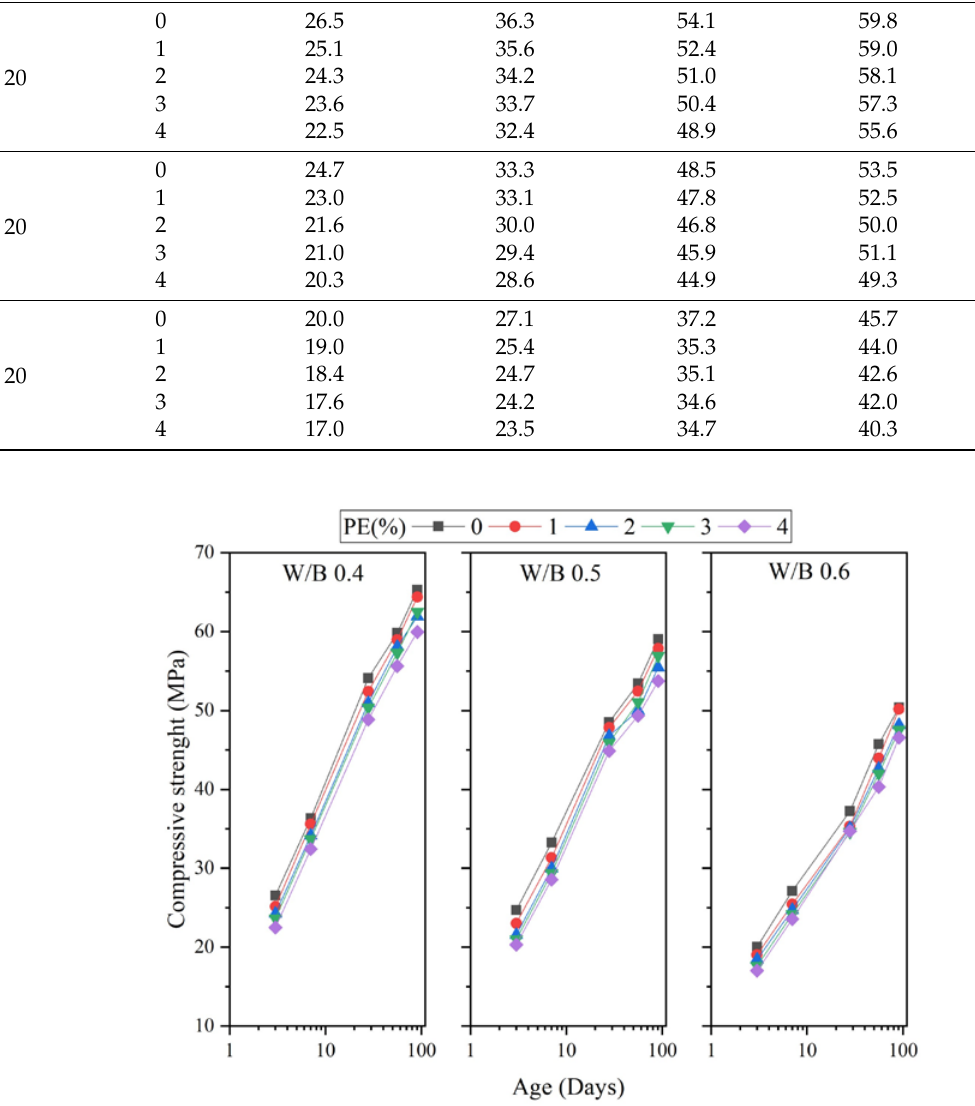
Figure 5. Compressive strength of cement mortar with different W/B ratios and waste PE.